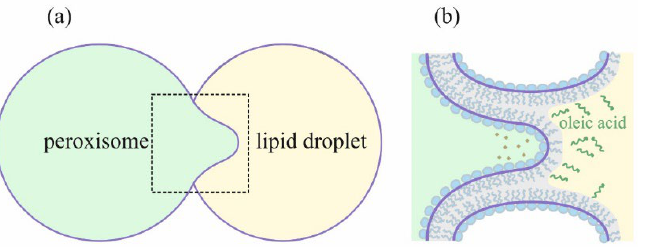
Figure 1. ( a ) Schematic representation of the peroxisome–lipid droplet membrane fusion. The region of membrane contact is marked with a dotted square. ( b ) Schematic representation of the pexopodia structure. Free fatty acids are denoted with green color. Beta-oxidizing enzymes are denoted as di- amonds.